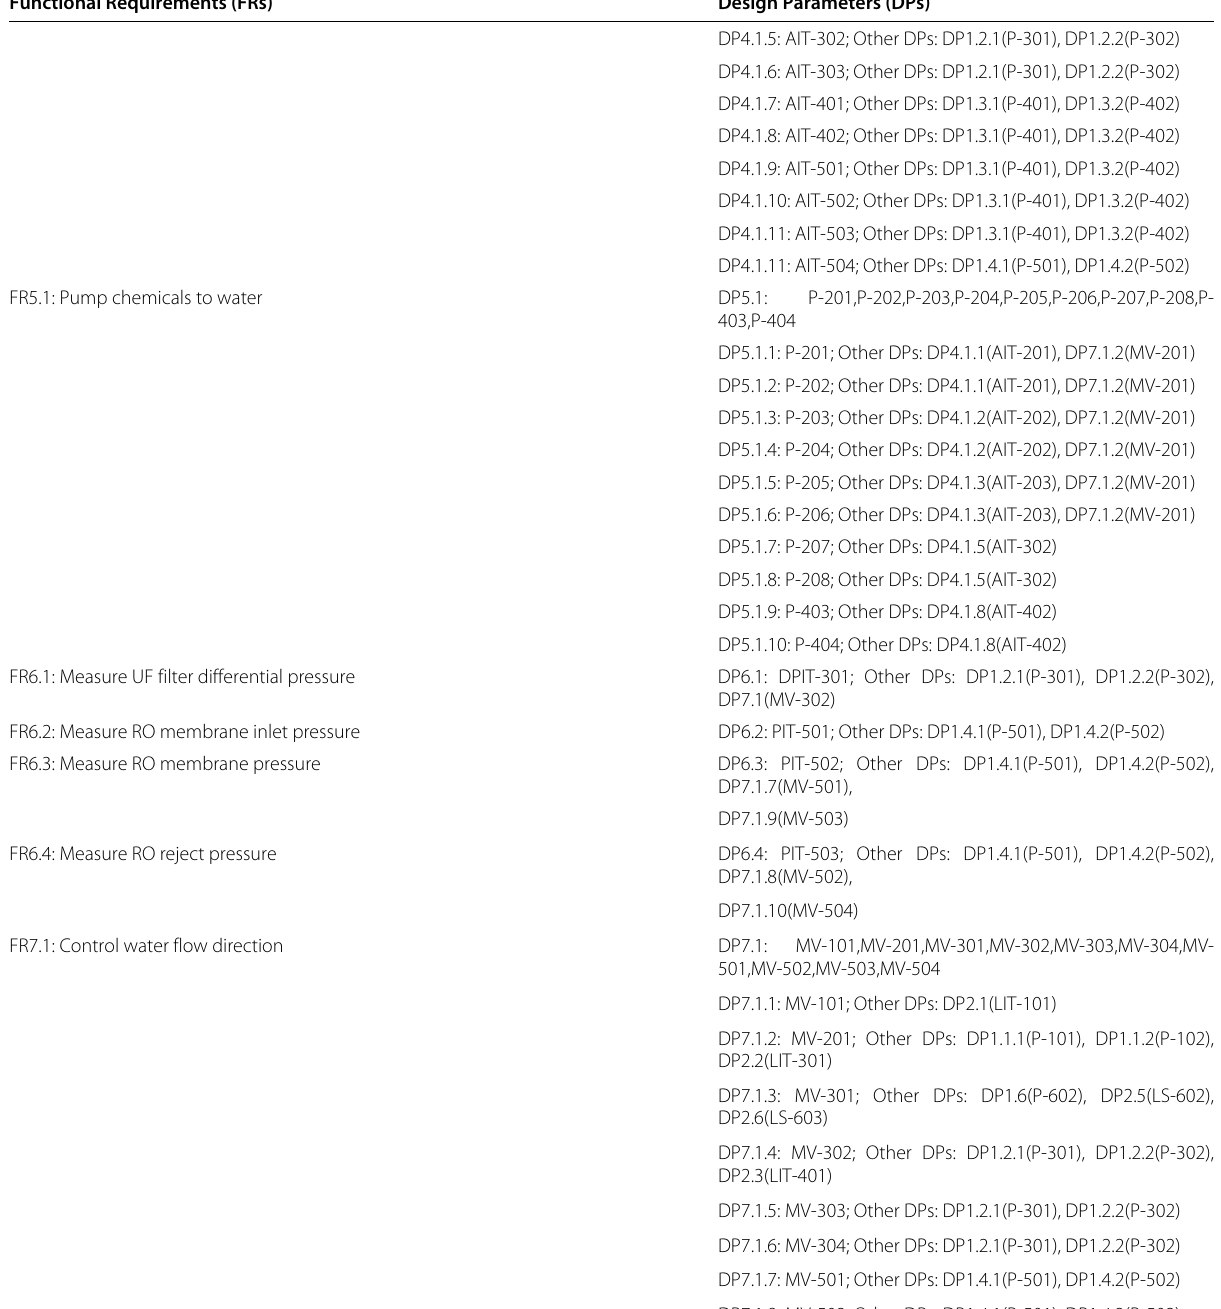
Table 4 Linking SWaT’s second-level decomposition of FRs to dependent DPs ( Continued ) Functional Requirements